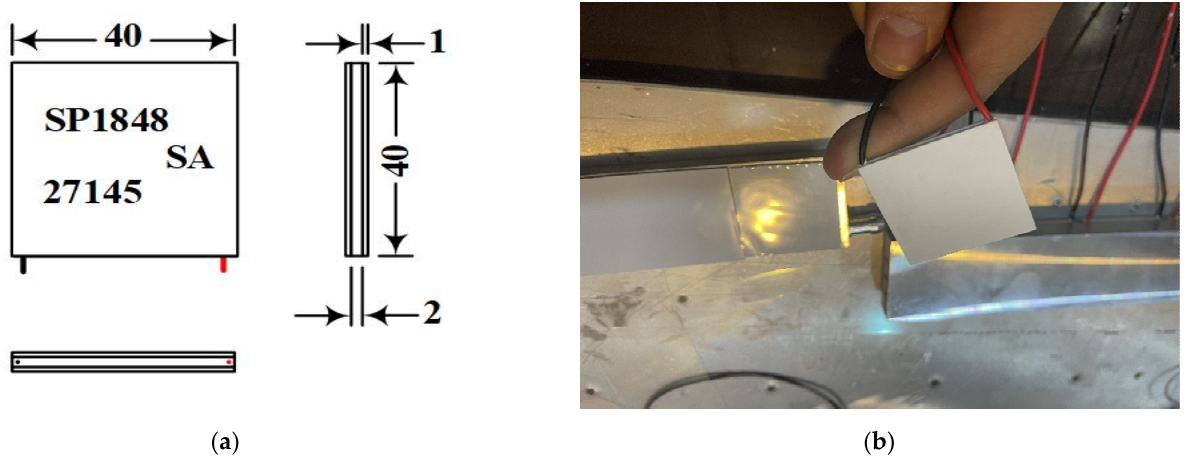
Figure 6. ( a ) Schematic diagram, and ( b ) image of single TEG module implementation.